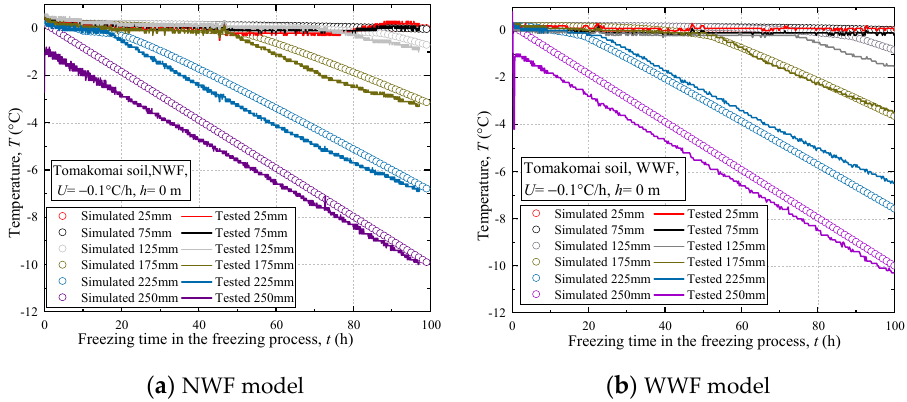
Figure 6. Comparison of the simulated and tested temperature development at the different observation points.